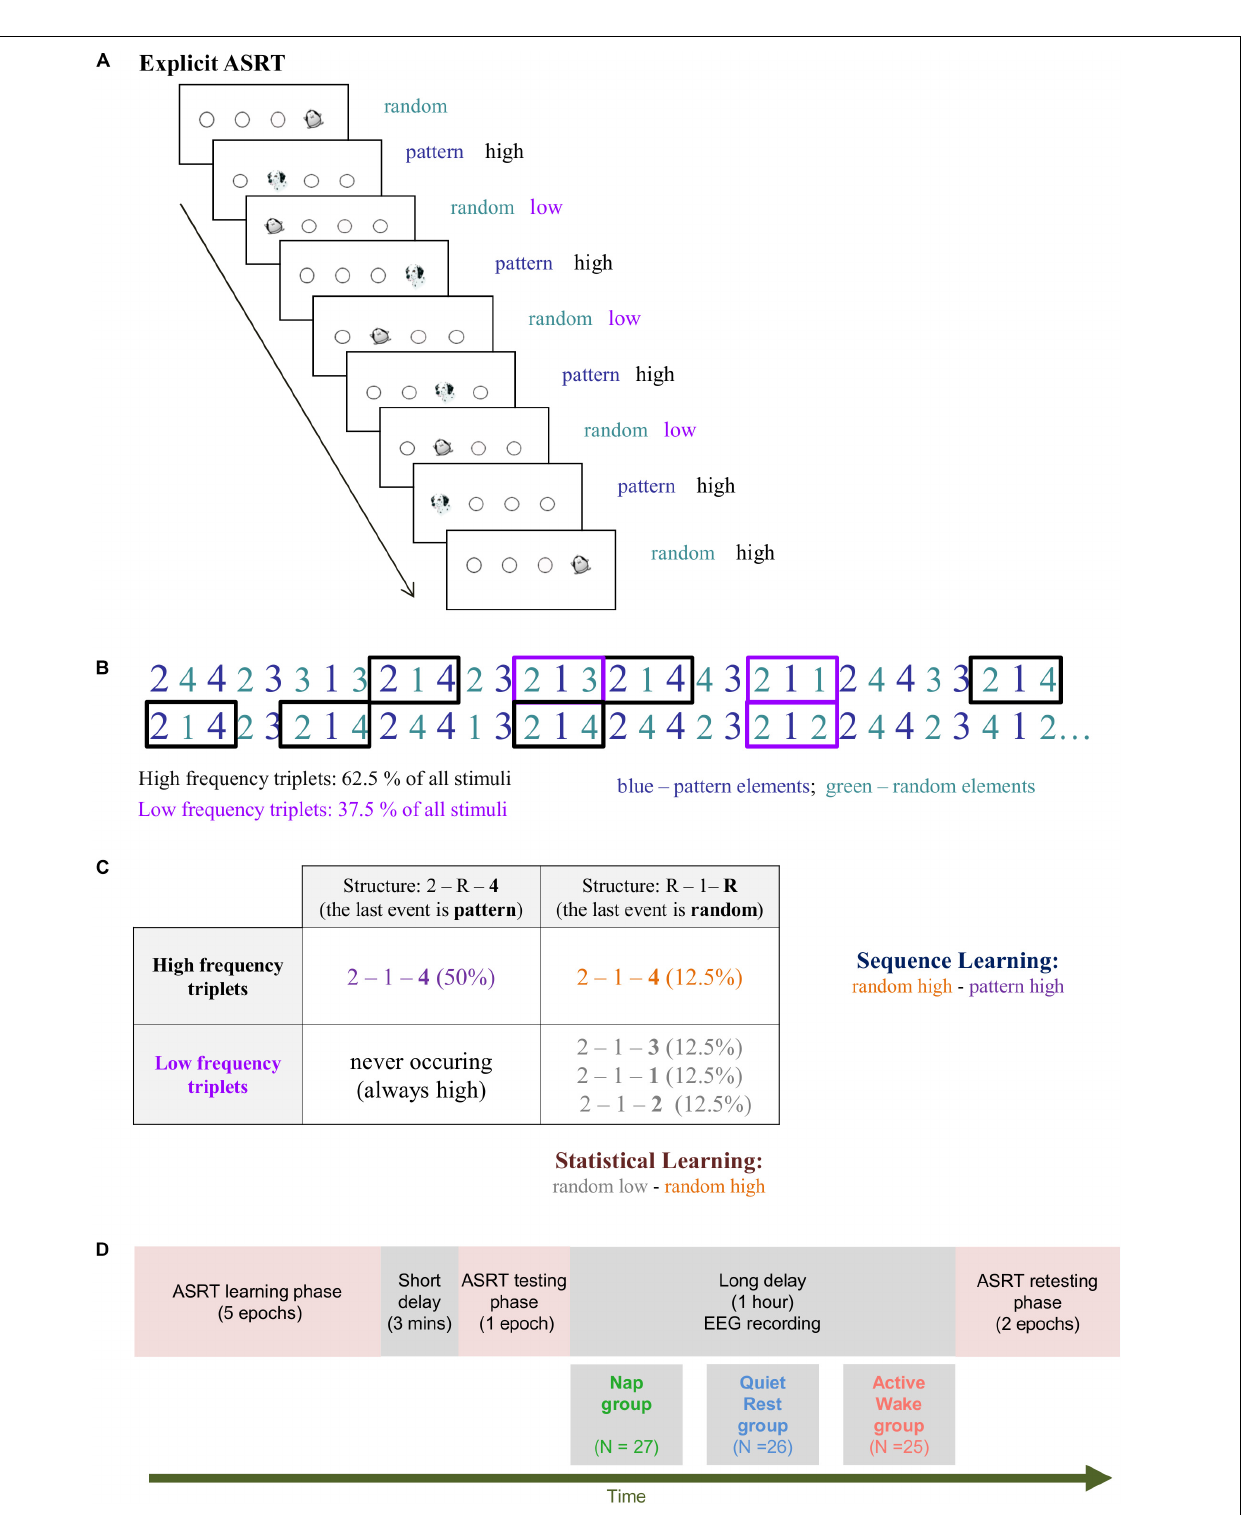
Frontiers in Psychology |